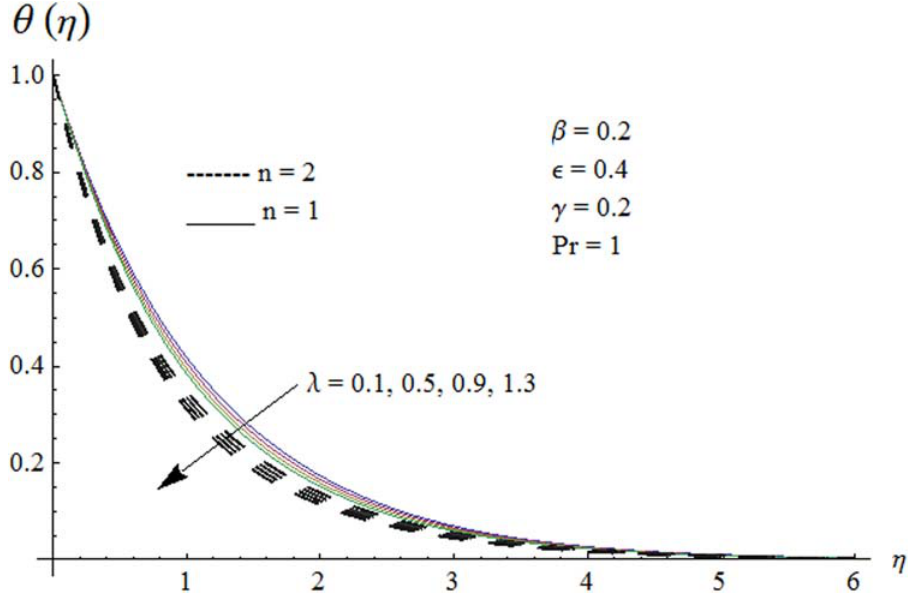
Fig 13. Effect of λ on temperature